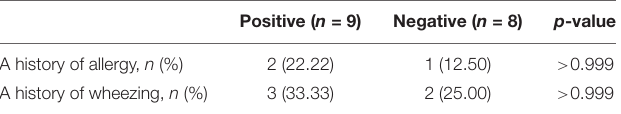
TABLE 8 | Comparison of clinical data between patients with negative and positive bronchial dilation